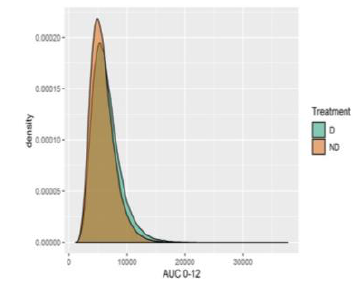
Fig. 8. Estimate the difference in mean log Clr between Metformin + Daclatasvir (D) and Metformin only (ND) groups